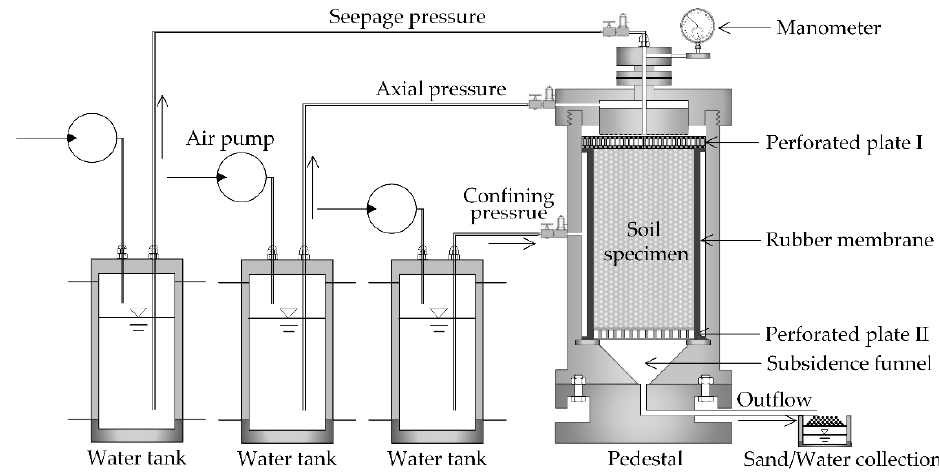
Figure 2. Schematic diagram of the seepage test apparatus.